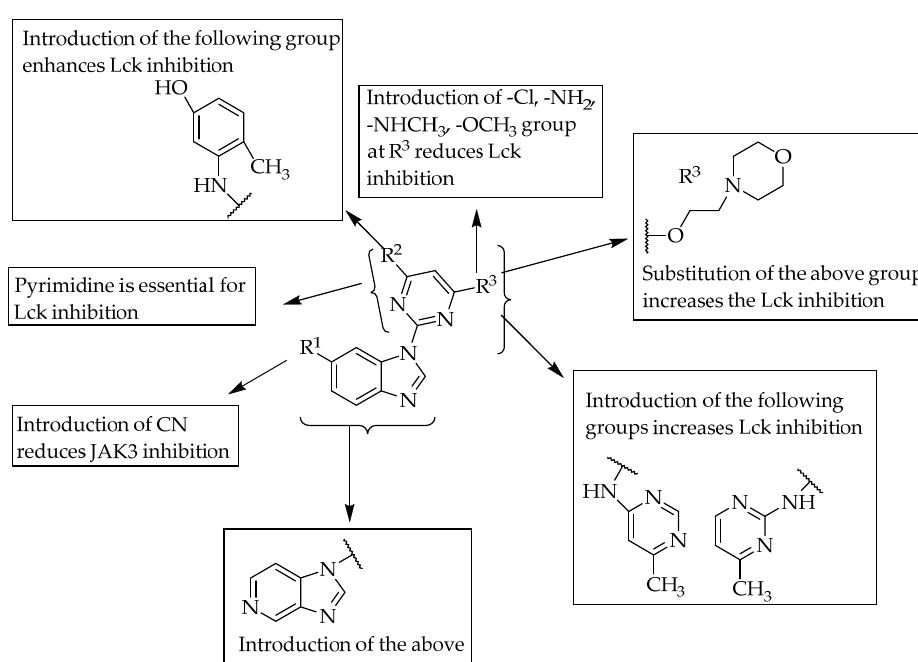
Figure 20. SARs of 2-benzimidazole substituted with pyrimidine.